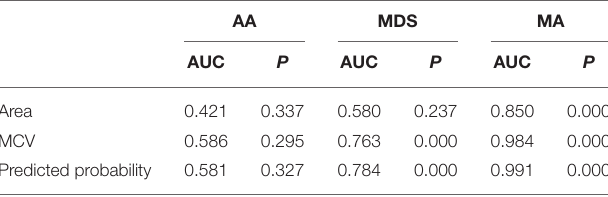
TABLE 4 | The AUC results of RBCs area, MCV, and predicted probability in patients with AA, MA, and MDS. AA MDS MA AUC P AUC P AUC P Area 0.421 0.337 0.580 0.237 0.850 0.000 MCV 0.586 0.295 0.763 0.000 0.984 0.000 Predicted probability 0.581 0.327 0.784 0.000 0.991